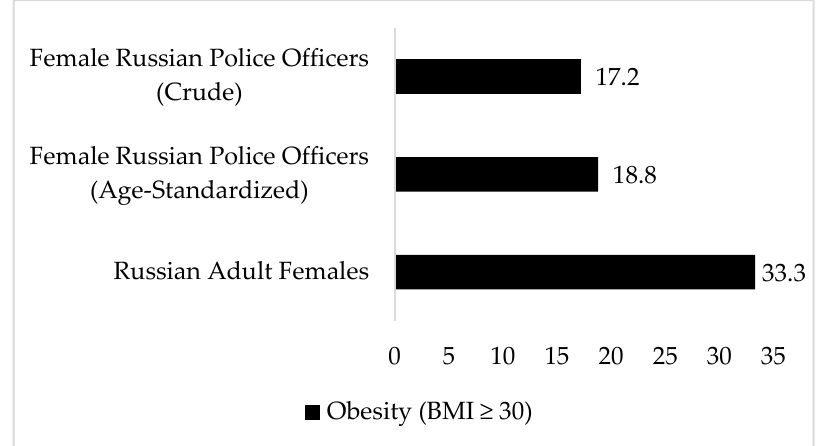
Figure 2. Age-standardized prevalence of obesity (BMI ≥ 30 kg/m 2 ) in female Russian police officers compared with Russian adults. Russian police officer rates were age-standardized using 2014 age- stratified population estimates for Russian females provided in the Central Intelligence Agency World Factbook for Russia [21]; Russian female obesity estimates are from the World Health Organization [22]. Table 1. Rates of false positives and false negatives using BMI-defined obesity classification in comparison to waist circumference (WC)-defined and body fat percentage (BF%)-defined obesity for men ( n =